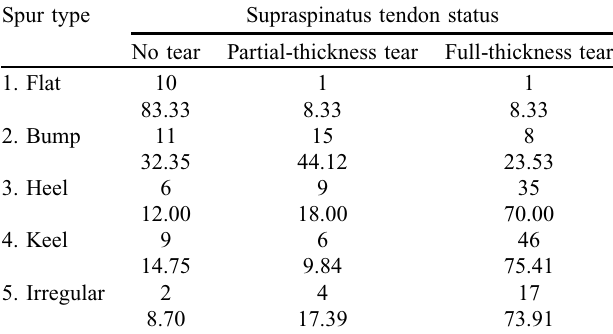
Table 4. Describes the prevalence of the supraspinatus tendon status according to the arthroscopic morphological